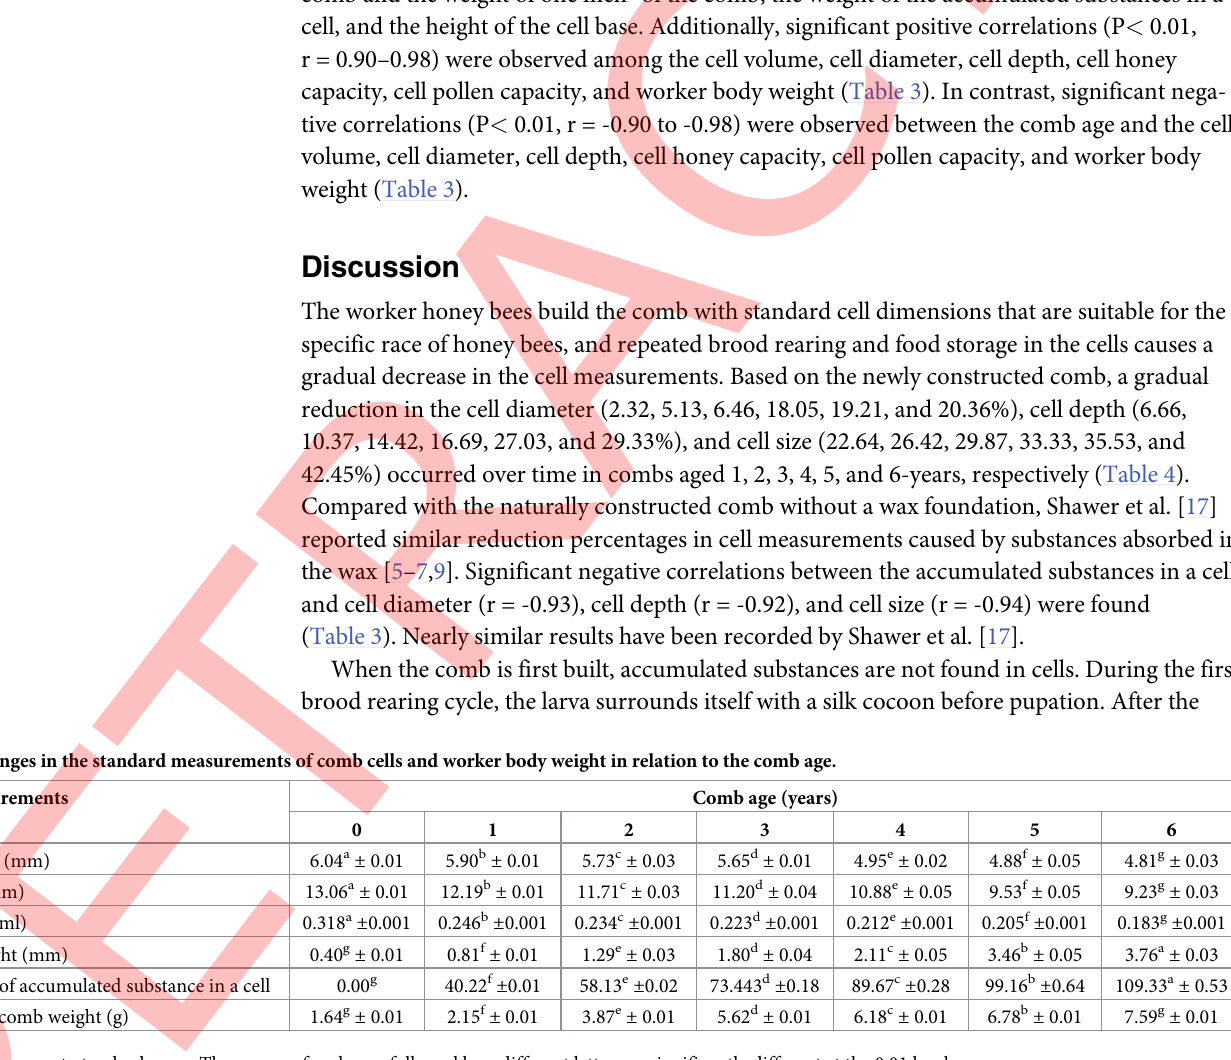
Values are the mean ± standard error. The means of each row followed by a different letter are significantly different at the 0.01